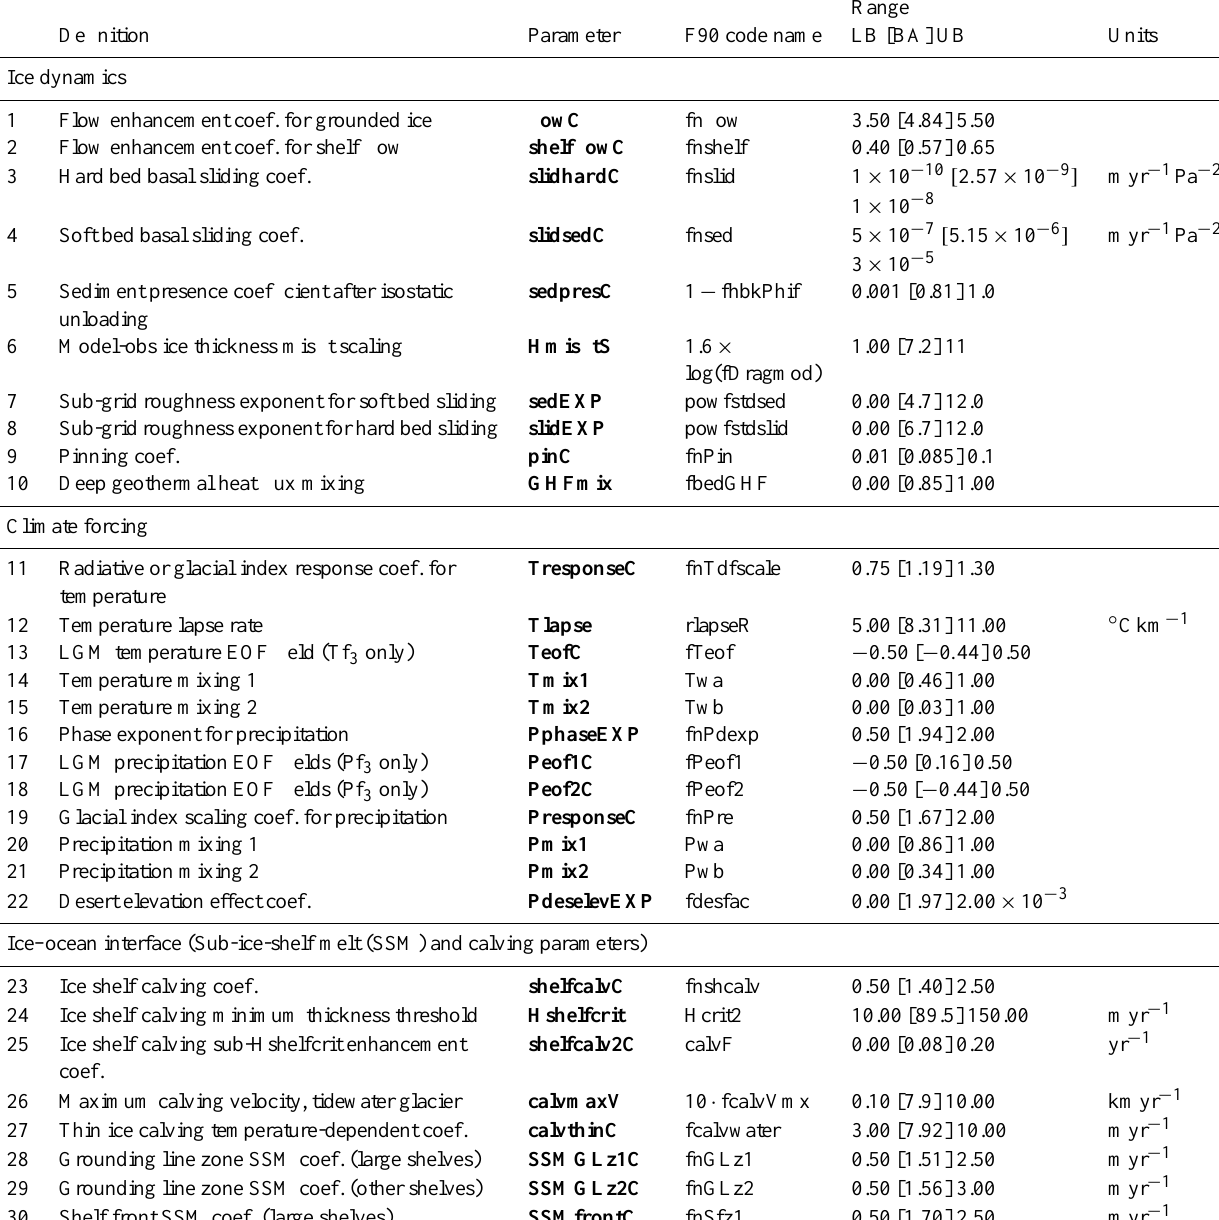
Table 2. Ensemble parameters. LB = lower bound, BA = baseline and UB = upper bound. Values are rounded to 2 decimal